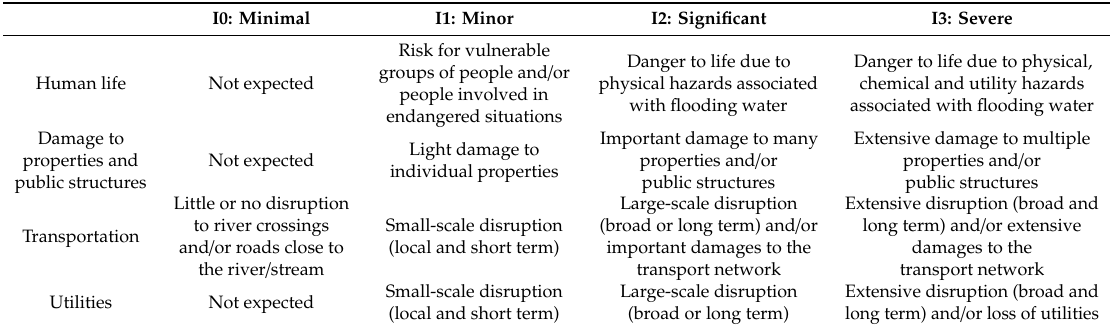
Table 2. Socio-economic impact intensity